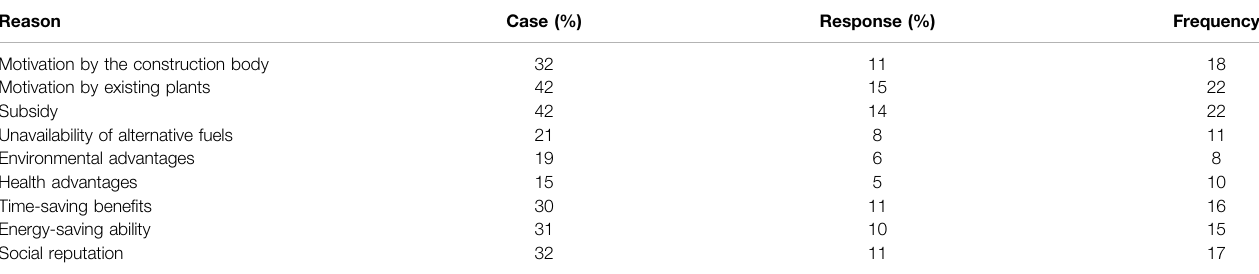
TABLE 1 | Factors motivating farmers ’ attention.